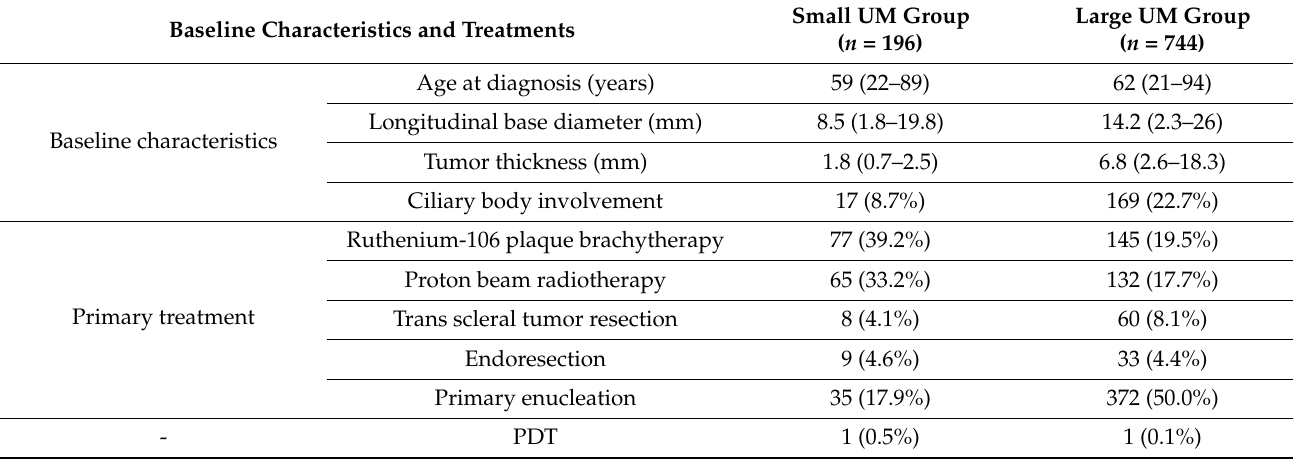
Table 1. Baseline patient and tumor characteristics (median and range) and primary treatment of small and large tumor